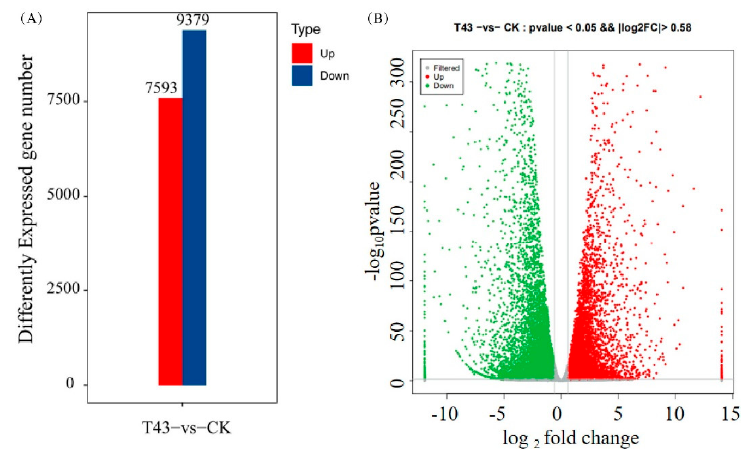
Figure 6. Analysis of overall results of di ff erentially expressed genes. ( A ) Number of di ff erentially expressed genes; ( B ) volcano analysis of di ff erentially expressed genes.